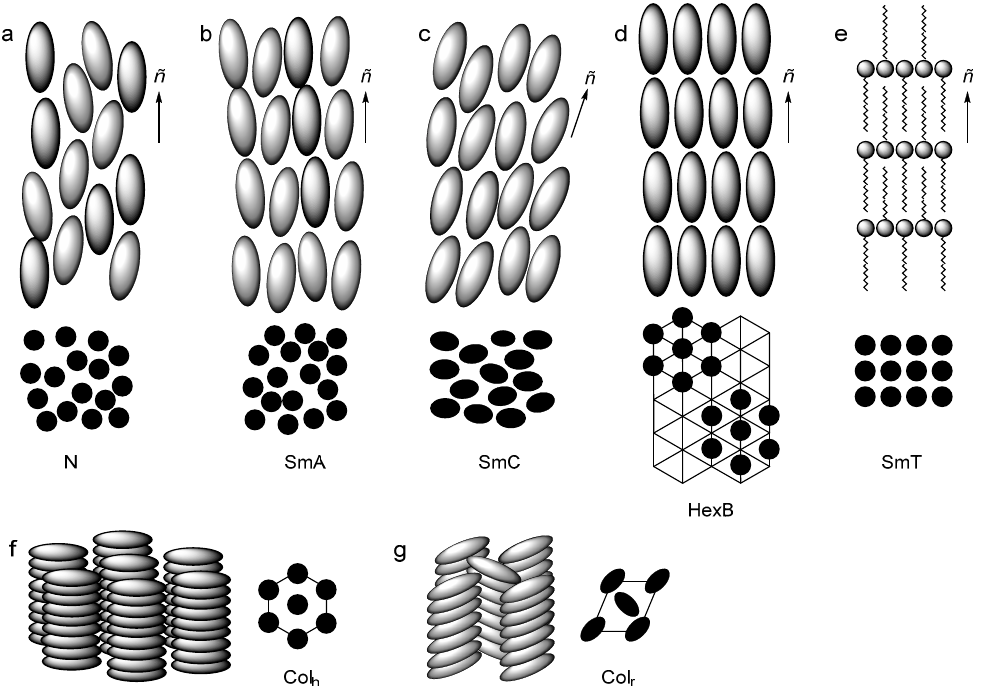
Figure 2. Schematic representation of a selection of frequently observed liquid crystal phases ( a – d ) for rod-shaped LCs; ( f , g ) for disc-shaped LCs and ( e ) selectively for ILCs. For all phases a side view (grey) of the phase and a top view (black) are given. The director ñ is indicated for every mesophase and is tilted with respect to the layer direction in the SmC phase. Phase abbreviations: N = nematic; SmA, SmC, SmT = smectic A, C and T, resp.; HexB = hexatic B; Col h , Col r = columnar hexagonal and rectangular, respectively.